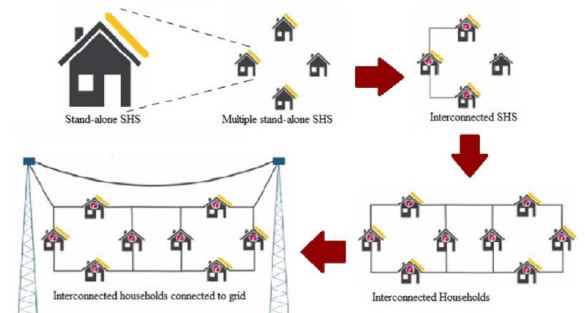
Figure 2: Swarm Electrification concept and stepwise approaches